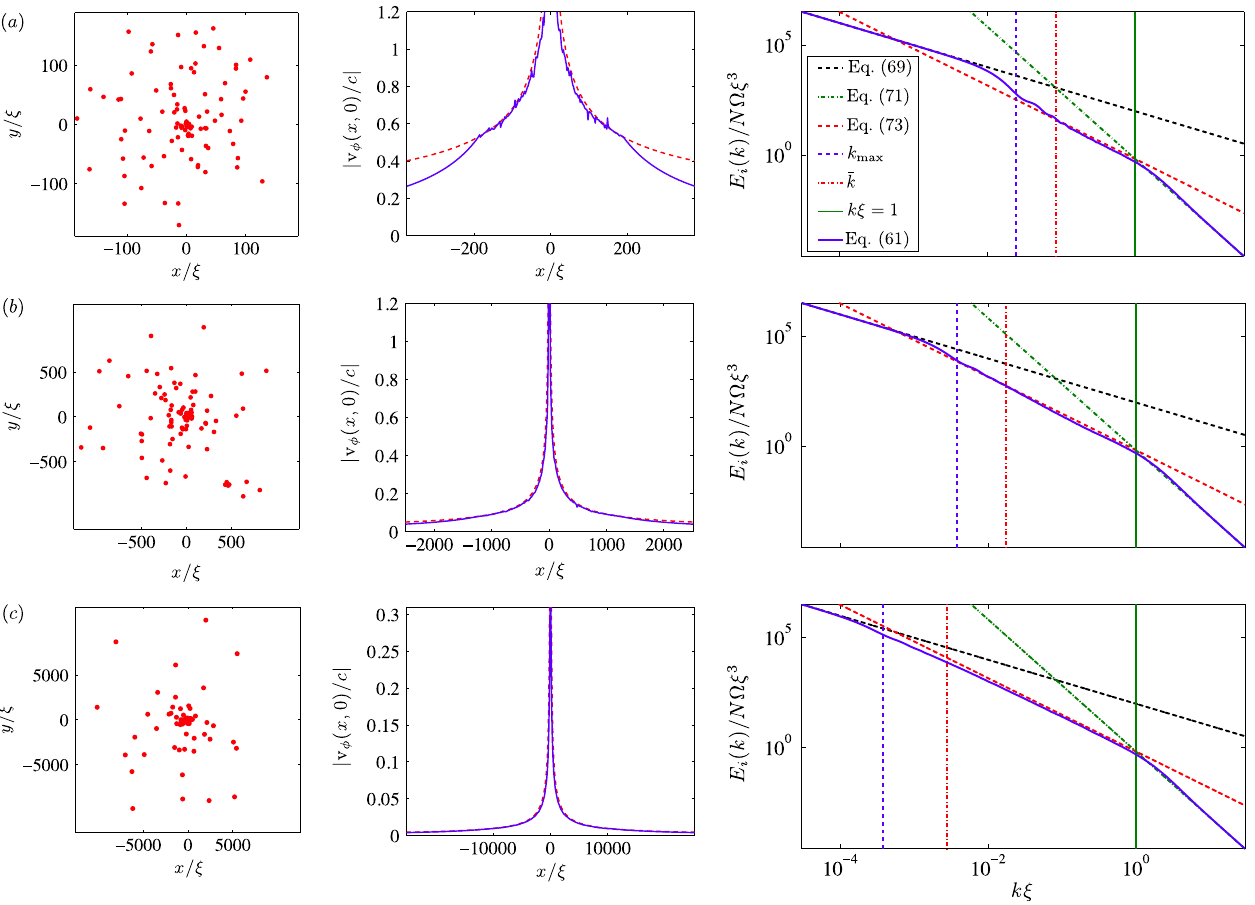
FIG. 4. Locations of N ¼ 100 vortices for particular samples (left), with velocity distributions [middle, with the analytical result (86) ¼ 100 samples distributed according to (81) and (82), (dashed line)], and kinetic-energy spectra (right, blue curves), averaged over n s ¼ (cid:1) , and (a) r ¼ 60 (cid:5)(cid:1) , (cid:5) (cid:7) ¼ 0 : 4 ; (b) r ¼ 400 (cid:5)(cid:1) , (cid:5) (cid:7) ¼ 0 : 65 ;, and (c) r ¼ 4000 (cid:5)(cid:1) , (cid:5) (cid:7) ¼ 0 : 83 . The increasing scale with r min max max max range of power-law behavior gives an inertial range in the corresponding kinetic-energy spectrum of approximately 1, 1.5, and 2 decades,